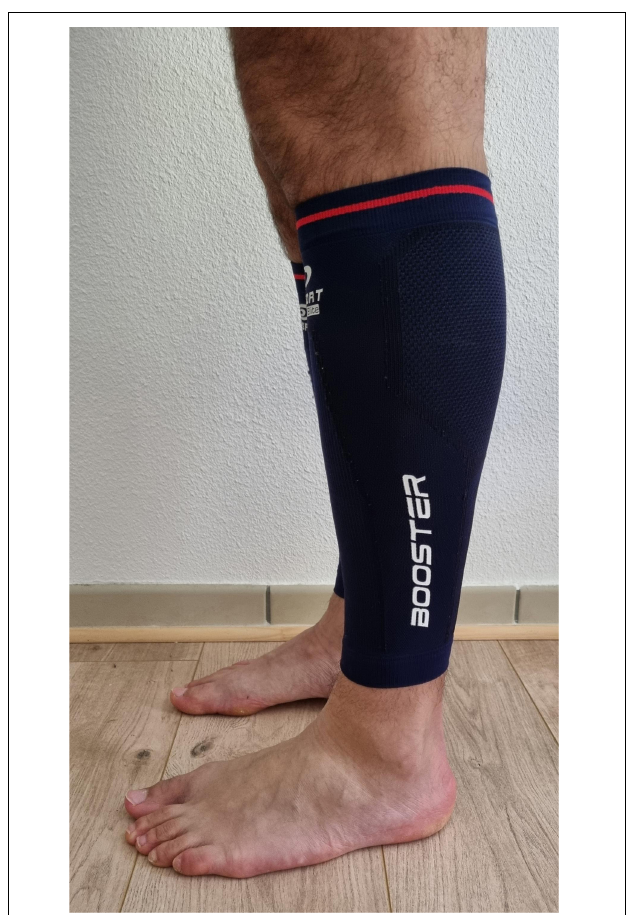
FIGURE 1 | Compression sleeves worn by participants in the compression garments (CG)